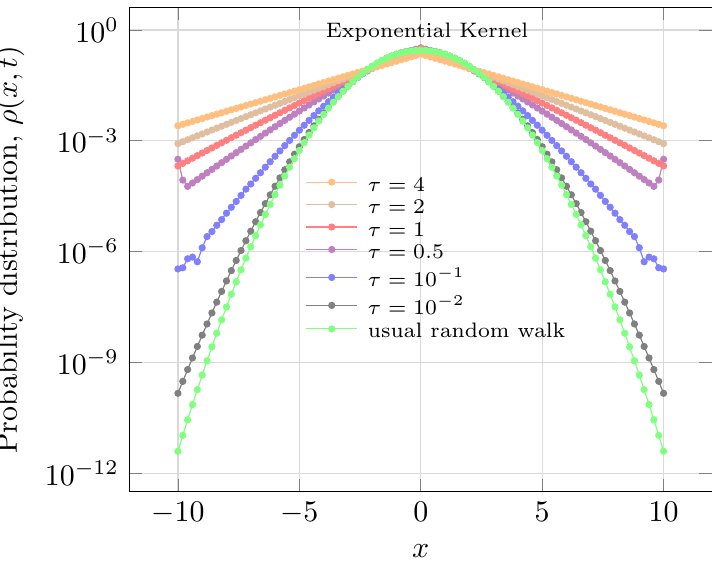
Figure 1. This curves illustrate the changes of distribution ρ ( x , t ) caused by the exponential kernel ( t ) = δ ( t ) (or (Equation (3) in Equation (1)), and the usual random walk (Brownian motion) case K f − 1 = 1, t = 1, and a family of characteristic times τ = 0 in Equation (3)), considering ϕ ( x ) = δ ( x ) , D f − 1 = α ) α − 1 and 10 − 2 ,10 − 1 ,0.5,1,2,4 (in context Caputo-Fabrizio operator τ = ( 1 { } − D